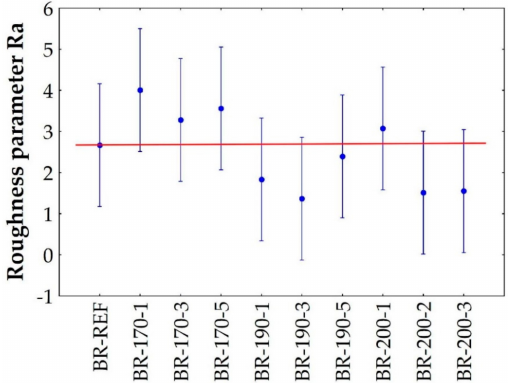
Figure 7. The graphic visualization of the e ff ect of heat-treatment temperature and heat-treatment time limit (peak stage) on roughness parameter Ra determined by optical method with label of values from the untreated birch (red line). BR-REF = untreated birch; BR-170-1 = birch treated at 170 ◦ C / 1 h; BR-170-3 = birch treated at 170 ◦ C / 3 h; BR-170-5 = birch treated at 170 ◦ C / 5 h; BR-190-1 = birch treated at 190 ◦ C / 1 h; BR-190-3 = birch treated at 190 ◦ C / 3 h; BR-190-5 = birch treated at 190 ◦ C / 5 h; BR-200-1 = birch treated at 200 ◦ C / 1 h; BR-200-2 = birch treated at 200 ◦ C / 2 h; BR-200-3 = birch treated at 200 ◦ C / 3